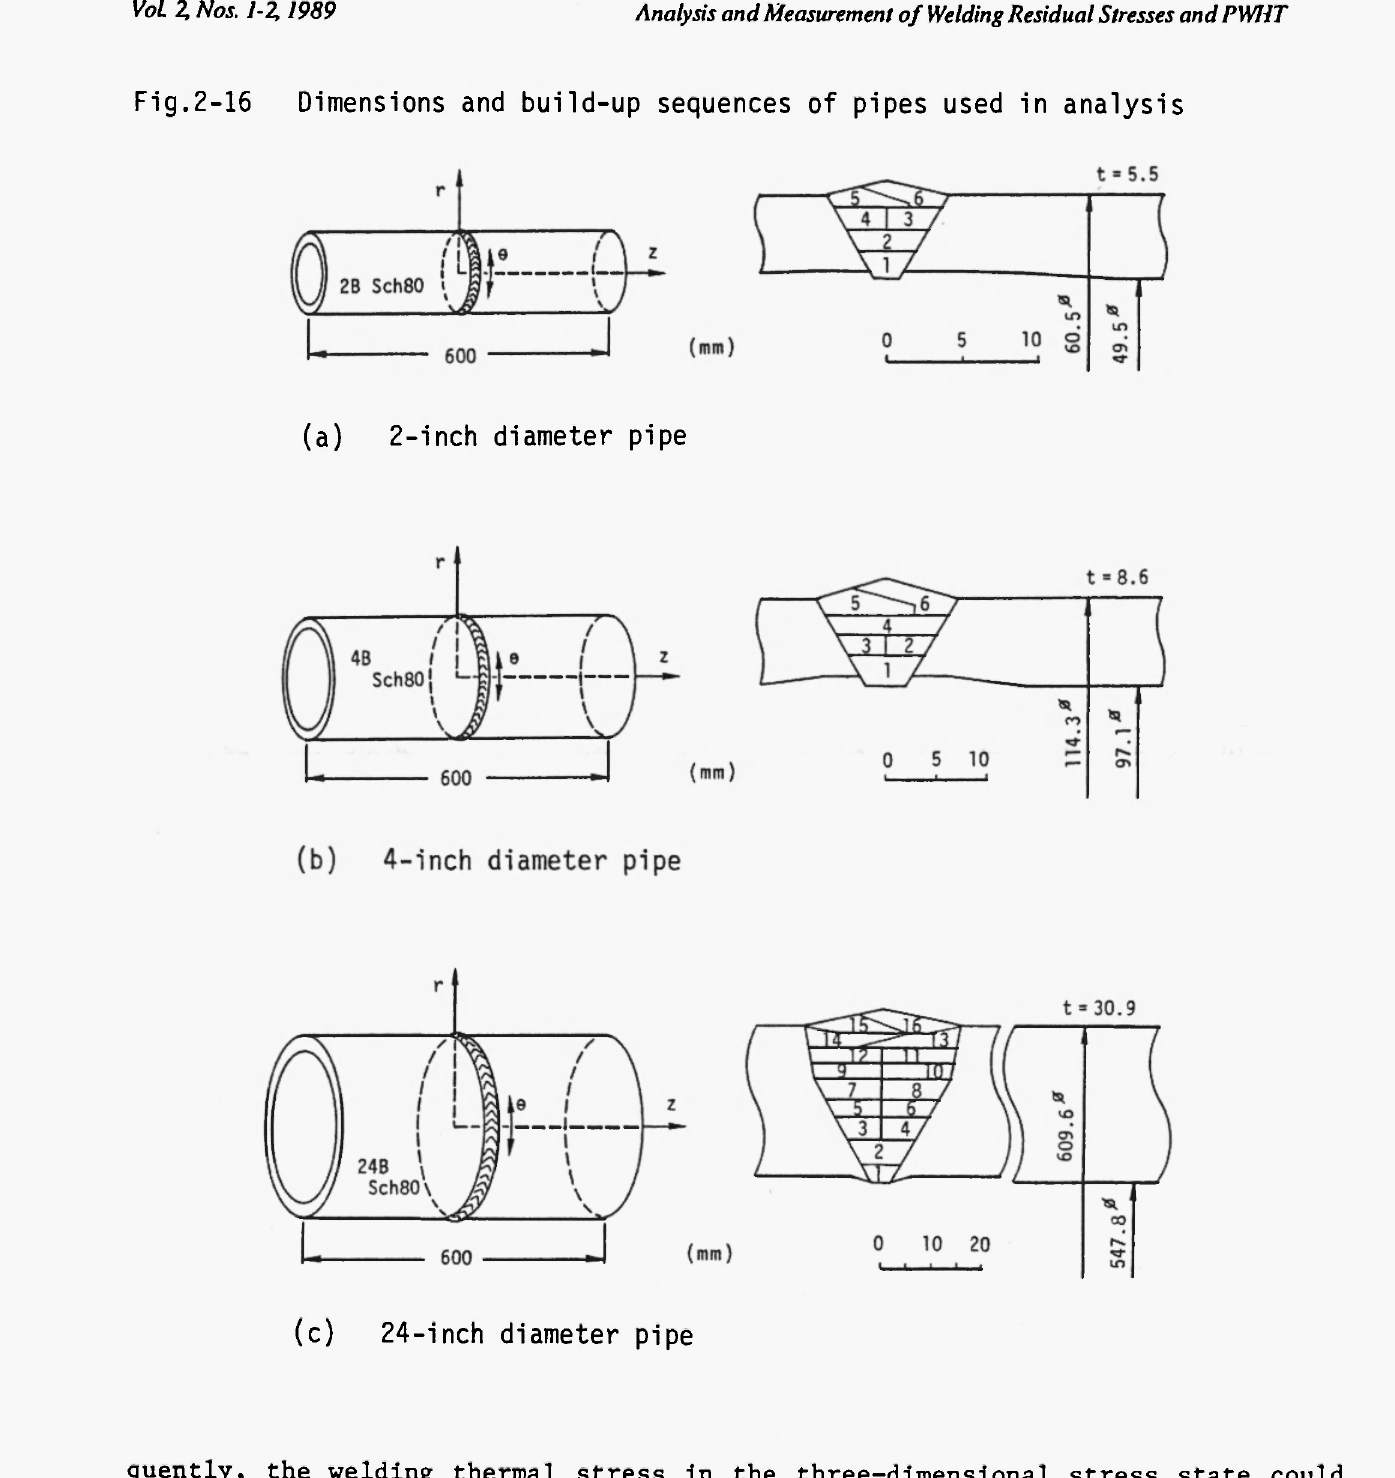
Fig.2-16 Dimensions and build-up sequences of pipes used in